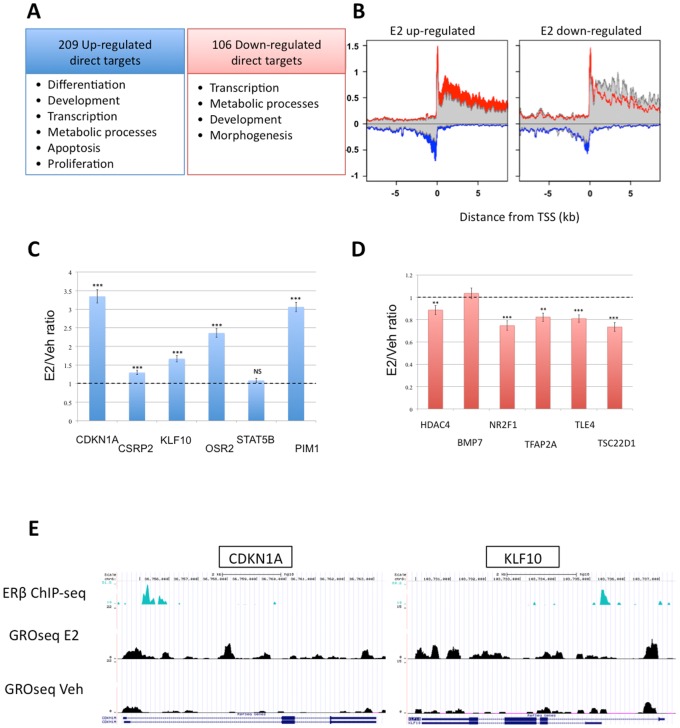
ERβ target genes identified by ChIP-seq and GRO-seq.A – Gene Ontology analysis shows that ERβ target genes are enriched in anti-proliferative processes such as differentiation and apoptosis. B – Metagene anslysis supports genes differentially regulated by ERβ upon E2 treatment. C, D – C4–12/Flag.ERβ cells were treated with E2 for 2 hours, after which mRNA was collected and reverse transcribed to generate cDNA. qPCR focusing on up-regulated (C) and down-regulated (D) genes identified by GRO-seq was used to validate differential gene regulation. (E) ERβ ChIP signal correlated with an increase of GROseq signal at the CDKN1A and KLF10 genes, two representative ERβ targets.